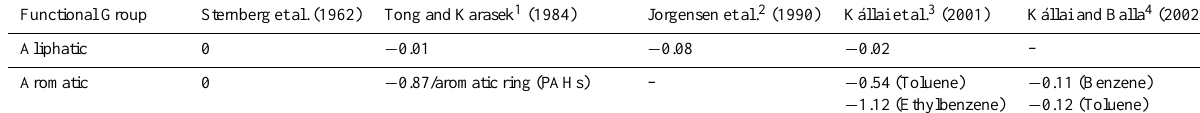
Table 1. ECN reduction by functional